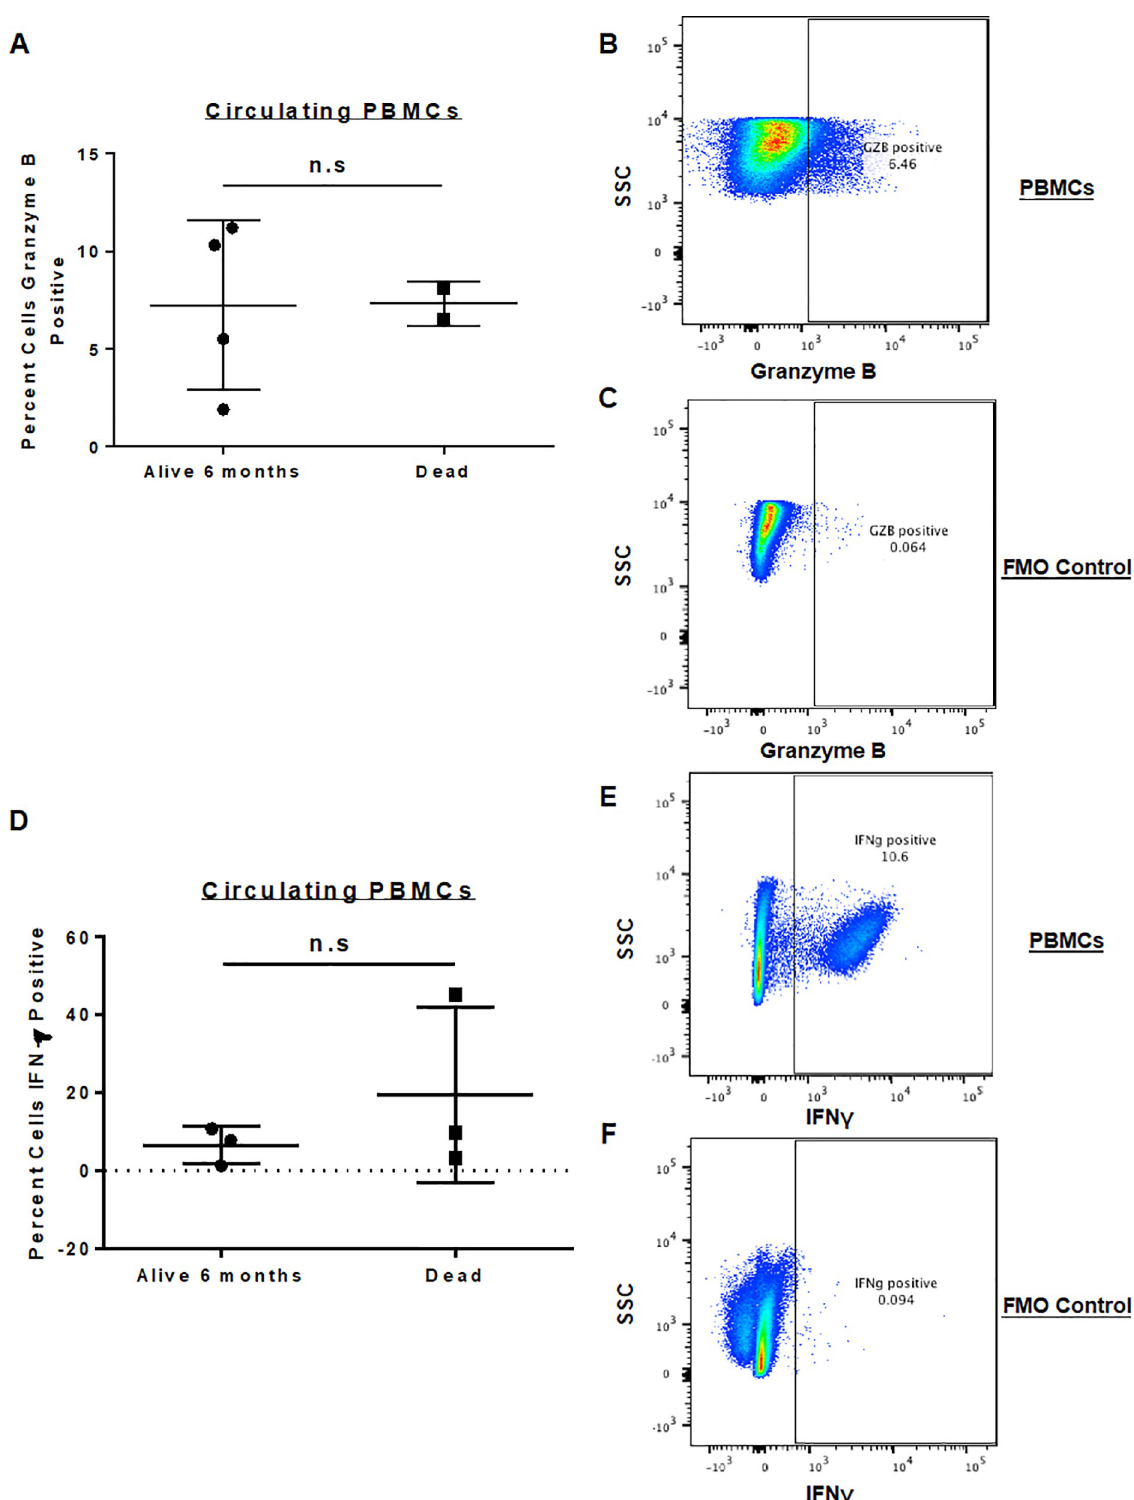
Fig 4. Expression of Granzyme B and IFN- γ in isolated peripheral blood mononuclear cells. PBMCs were isolated from dog patients on trial and analyzed via flow cytometry for the expression of activation markers. Baseline PBMC expression between dogs who were alive at 6 months versus those who died showed no significant difference in percent granzyme B positive (A) or percent IFN- γ positive PBMCs (D). Representative flow cytometry staining for granzyme B (B) with FMO control (C) and IFN- γ (E) with FMO control (F) is shown. https://doi.org/10.1371/journal.pone.0224775.g004 PLOS ONE | https://doi.org/10.1371/journal.pone.0224775 February 21,